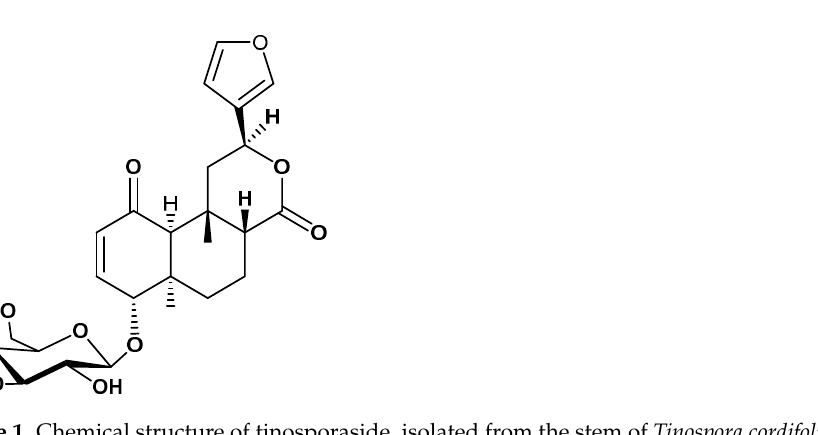
Figure 1. Chemical structure of tinosporaside, isolated from the stem of Tinospora cordifolia .